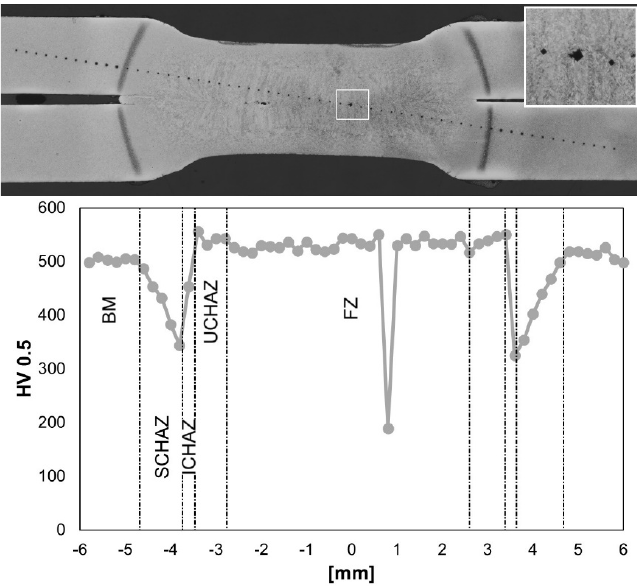
Figure 9. Microhardness profile in the cross-section of the weld joint (7 kA, Zn coated) with indication